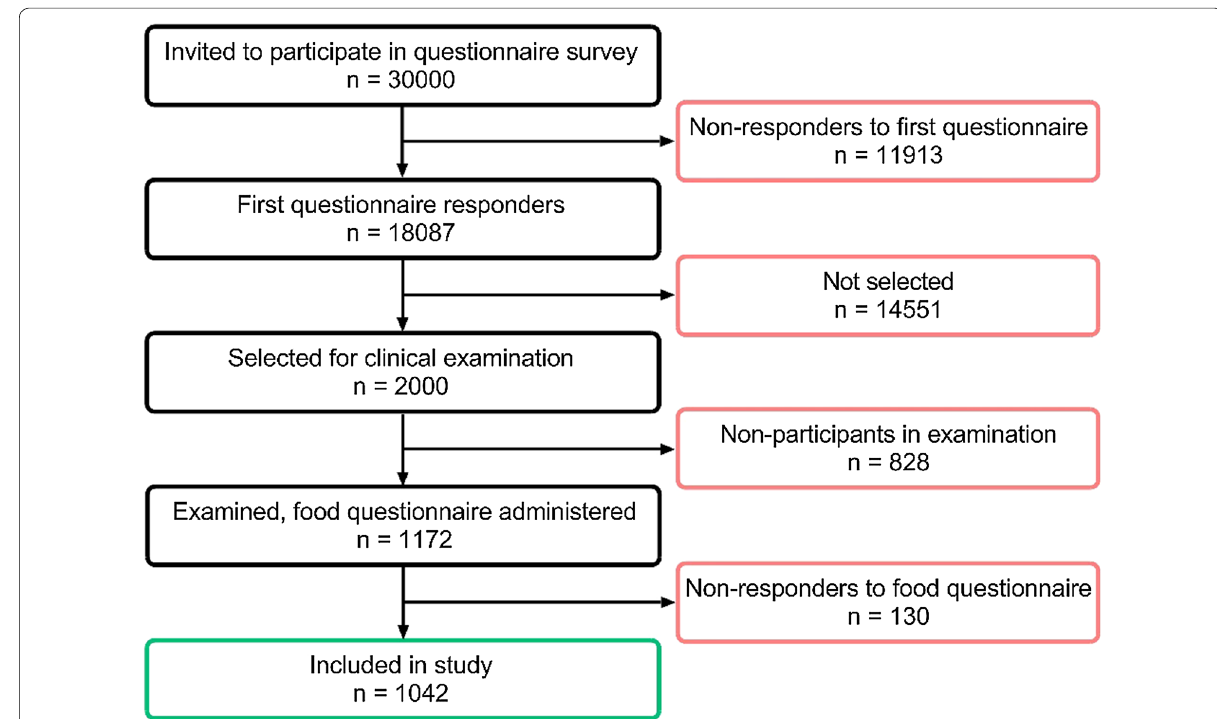
Fig. 1 Flow-chart for the selection of participants to the study and number of responders, non-responders